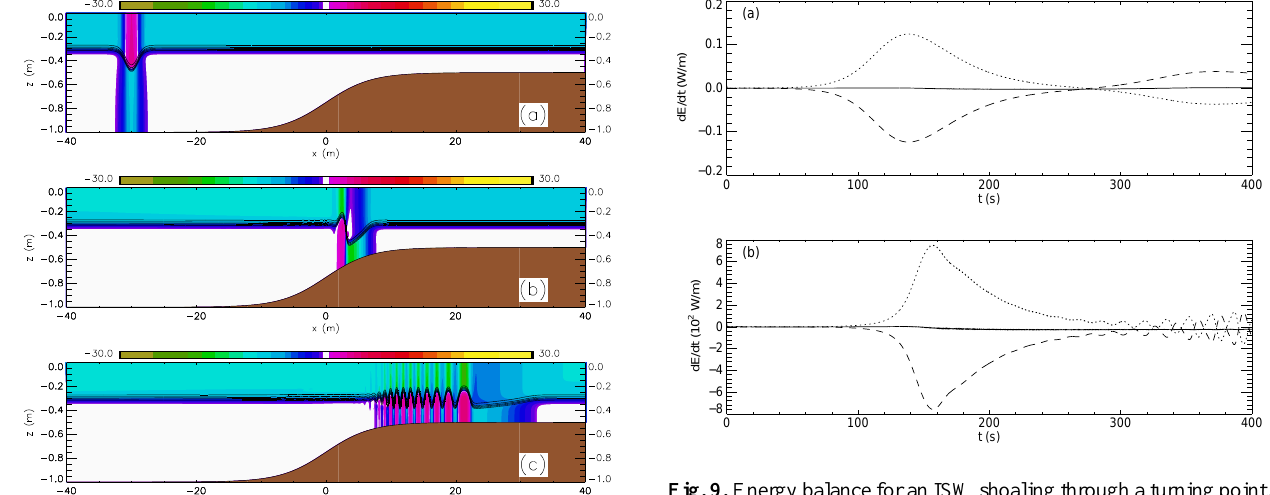
Fig. 7. Contour plots of the density field (solid lines) and horizontal velocity field (colours) for an ISW shoaling through a turning point. (a) Initial wave ( t = 0). (b) t = 150s. (c) t = 300s. The white regions indicate regions where | u | < 0 . 0013ms − 1 .